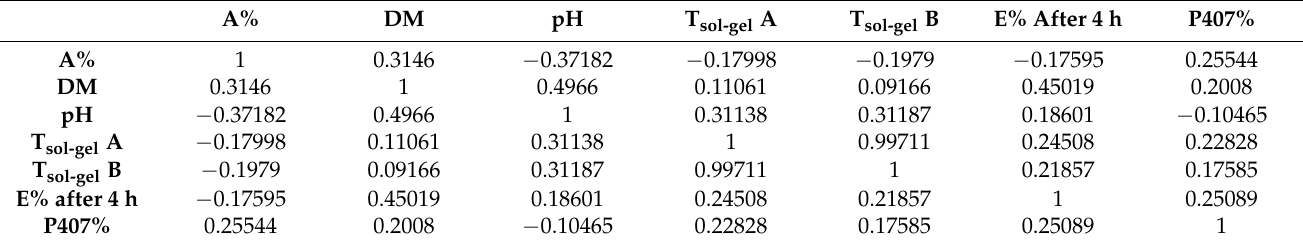
Figure 3. Loading plot of the first two PCs and the eigenvectors of the attributes ( A ). 3D score plot of the first three PCs, being the blue color attributed to the formulations based on water, while the red color of the formulations based on PBS ( B ). The amount of variance explained by each PC is therein represented at the graph label. Table 3. Correlation matrix of the attributes used in PCA analysis. A% stands for additive %, DM stands for dissolution medium, and E% after 4 h stands for erosion after 4